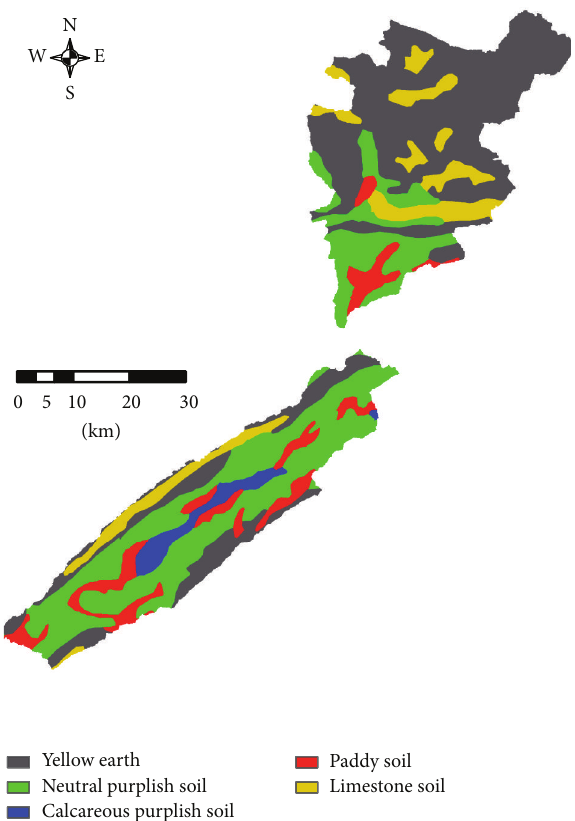
Figure 3: Soil maps of the Pengxi River